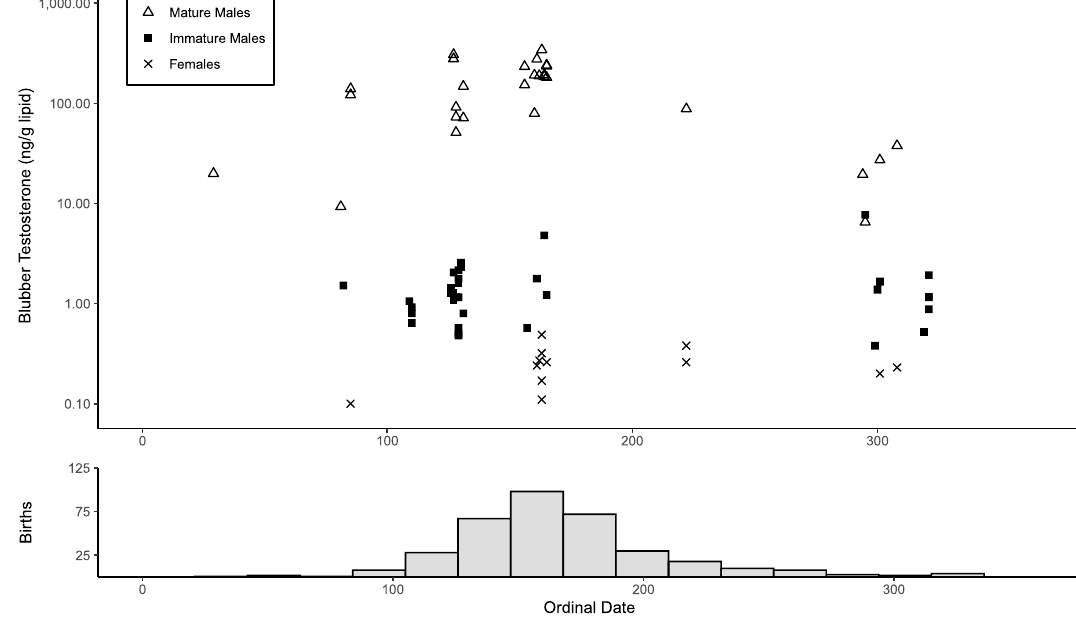
Figure 3. Top: Blubber testosterone (ng/g lipid mass) concentrations by ordinal date sampled for each demographic group of T. truncatus from Sarasota Bay, FL. Bottom: Unpublished data by R. S. Wells, 2020, frequency of T. truncatus birthdates from 1976–2020 (n = 353) binned in 3-week intervals in Sarasota Bay, FL. The expectation is that testosterone measurements would be the greatest before and near the peak calving period as gestation is estimated to be approximately 12.5 months, and testosterone increases are associated with seasonal testis development 54 .